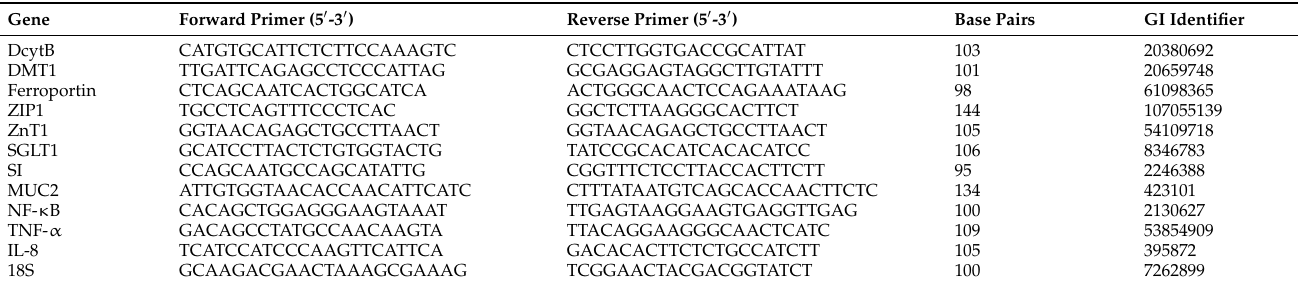
Table 2. Real-time polymerase chain reaction (RT-PCR) primer sequences.